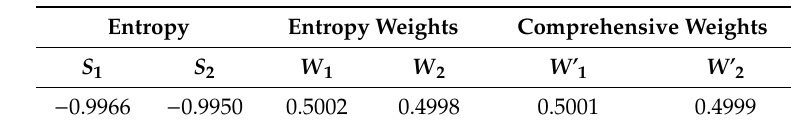
Table 3. The results of objective weightings and comprehensive weightings of QAs’ infrared and ultraviolet